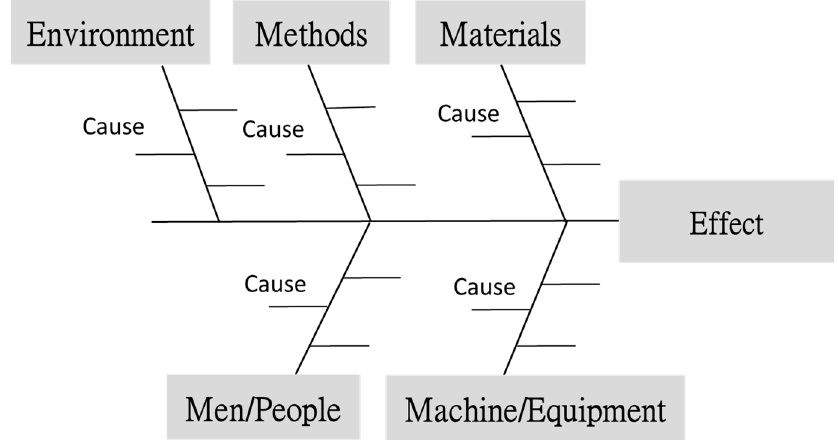
Figure 6. Illustration of a general cause-and-effect diagram.